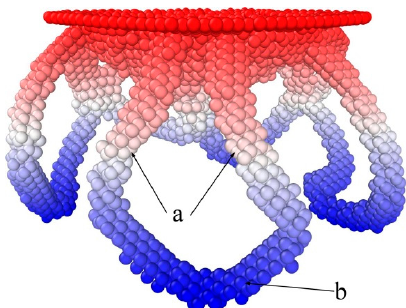
Figure 10. Dislocation loops during indentation, where “a” and “b” indicate screw and edge components, respectively.